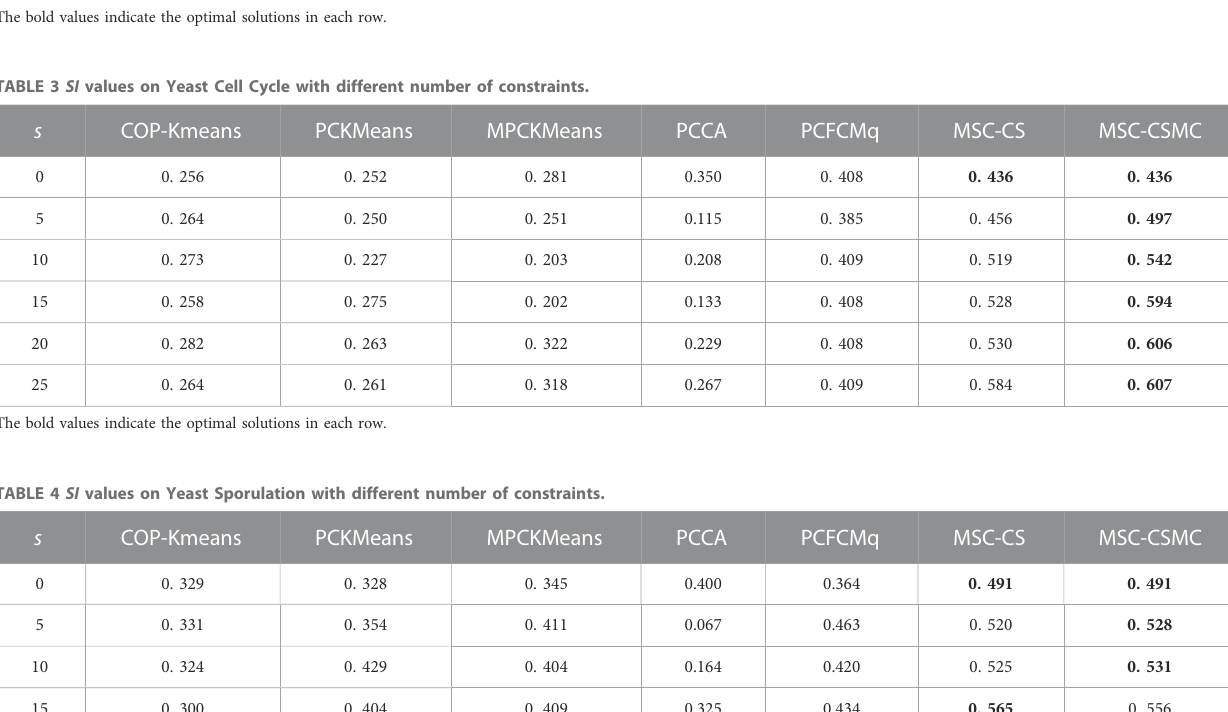
The bold values indicate the optimal solutions in each row.